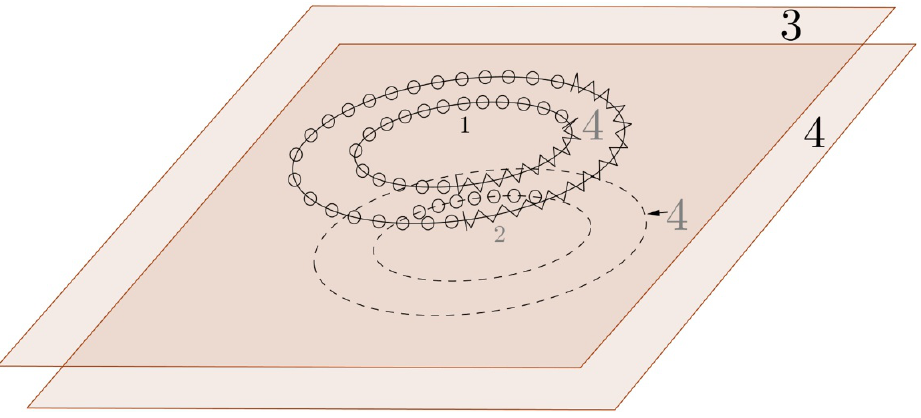
Figure 24 . Here we have drawn the markings , and along the edge of the comple- ment 3 and along the pieces of edge for respectely on disc 2 and on disc 1.